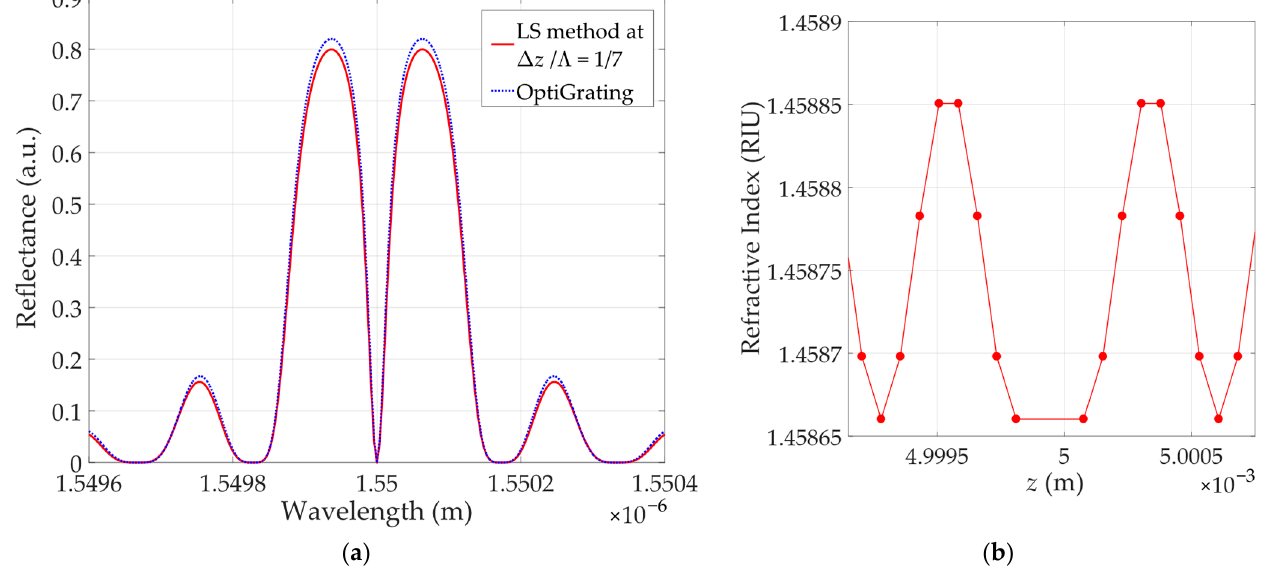
Figure 11. Modeling results of the π -phase-shifted FBG using the Layer Sweep method with the partition interval of Δ z = (1/7) × Λ : ( a ) resulting spectra: of LS method (red solid line), OptiGrating spectrum (blue dotted line); ( b ) and refractive index profile of the modeled grating.